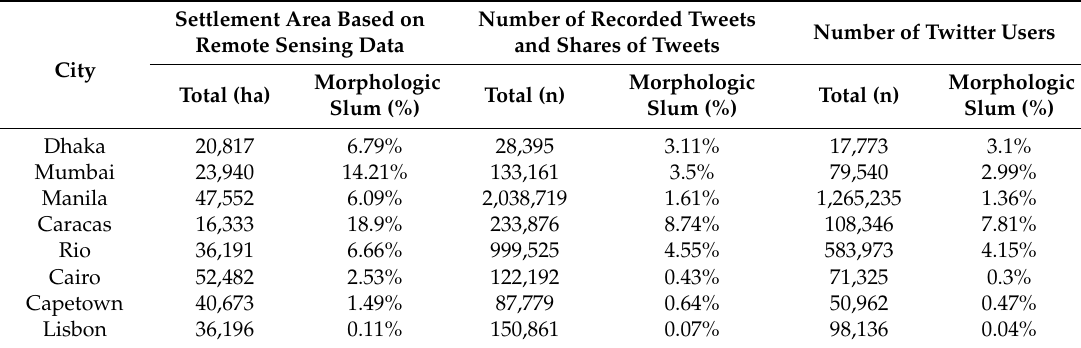
Table 1. Detailed spatial classification results of settlement areas, spatial shares of morphologic slums, number of recorded tweets and tweets in morphologic slums and related numbers of users.